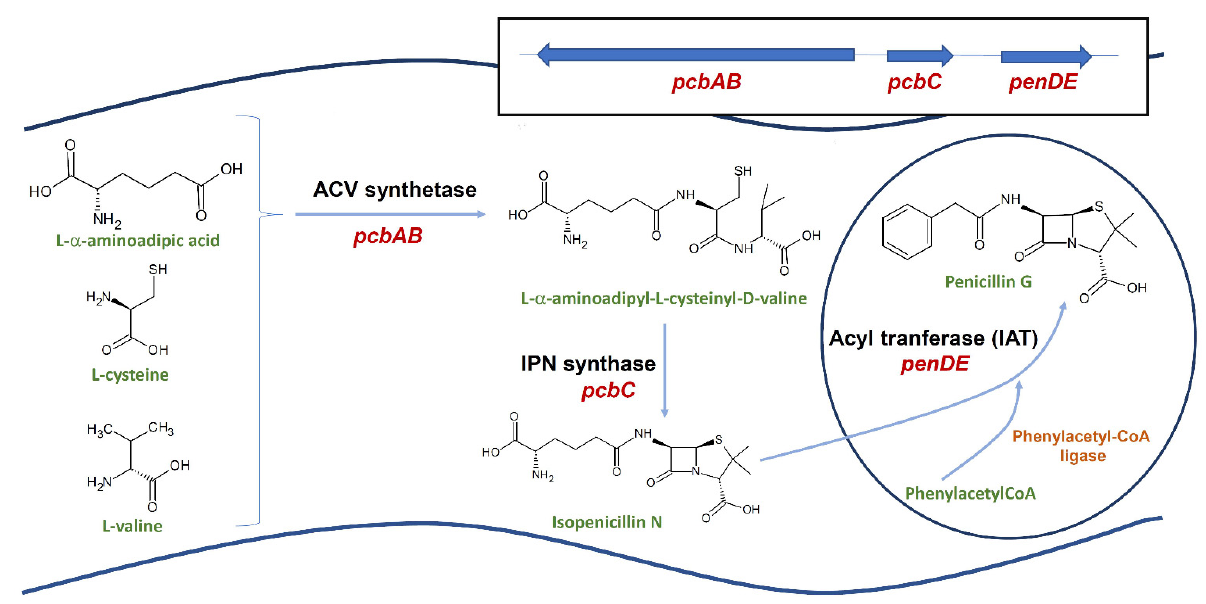
Figure 1. Outline of the penicillin biosynthetic pathway, showing the enzymes involved and the clustered genes encoding each enzyme.